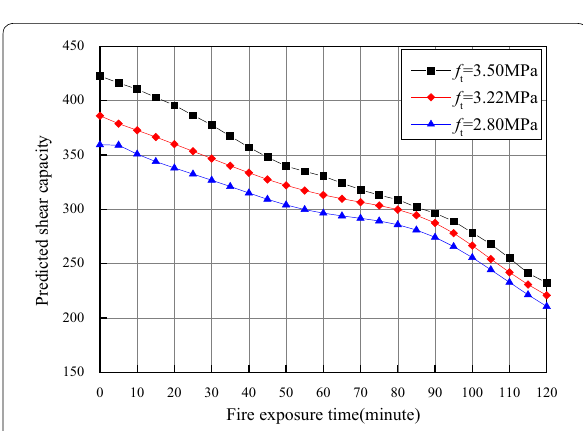
Fig. 12 Effect of concrete tensile strength f t on shear resistance of beams.